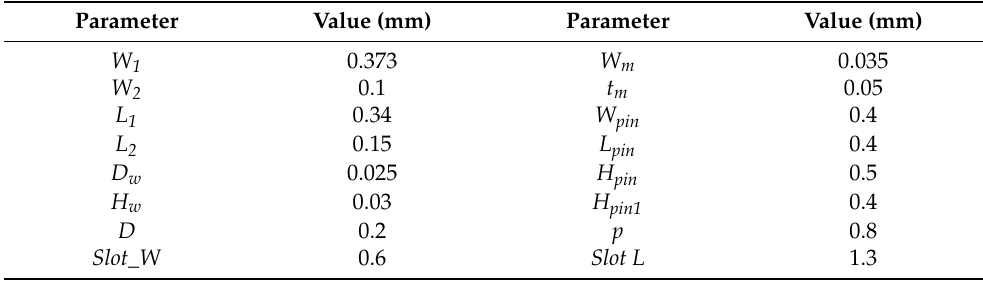
Table 1. Optimum geometry parameters for the MMIC-to-GWG transition, based on the glide- symmetric holey EBG.